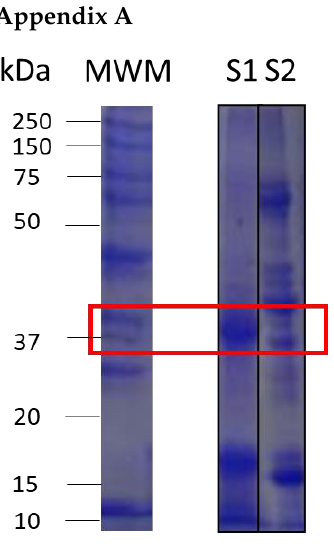
Figure A1. SDS-PAGE of protein extracts of shrimp samples (MWM: molecular weight marker; S1 and S2: shrimp samples 1 and 2).